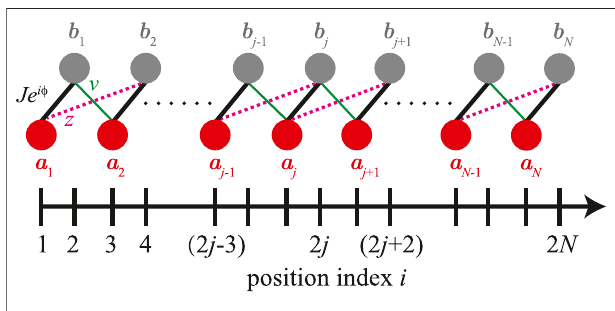
FIGURE 1 | (Color online) Schematic diagram of a generalized SSH model based on an optomechanical array. a j and b j denote the cavity and mechanical modes respectively, and they are coupled with three different hopping amplitudes Je i ϕ (bold black lines), v (thin green lines) and z (red dashed lines). The optomechanical array can be implemented by an array of coupled optical microdisks [7 – 10], on-chip superconducting circuit electromechanical cavities [11 – 14], and optomechanical crystals [15,